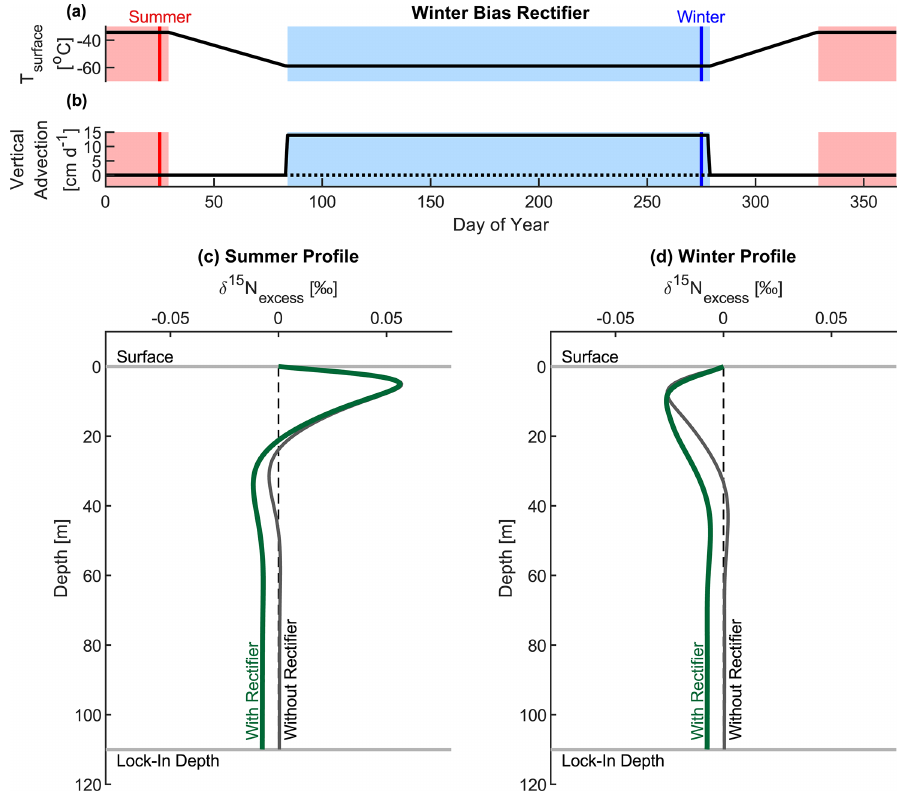
Figure 8. Results of idealized modeling experiment. Panels (a) and (b) show the temperature and advection forcing applied to the firn air model. The solid lines correspond to the “with rectifier” run, and the dotted line in (b) corresponds to the “without rectifier” run with no vertical advection. Panels (c) and (d) show the vertical profile of δ 15 N excess in the firn column at the end of summer and winter respectively. The grey line is the run without advection, and the green line is with advection. The days corresponding to the profiles are indicated by the vertical red and blue lines in the upper panels. An animated version of this figure is available in the Supplement as Movie